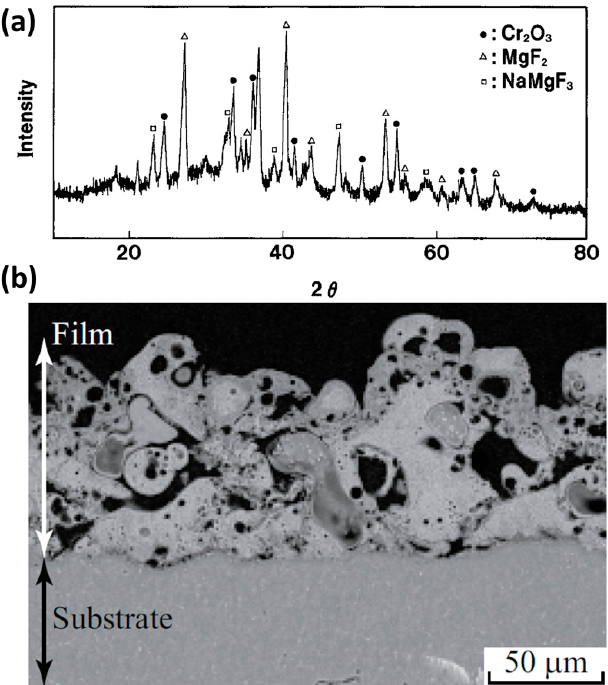
Figure 7. ( a ) X-ray diffraction pattern [71] and ( b ) backscattered electron cross-sectional micrograph of DOW17 coating on AZ91 alloy [72], the latter produced by applying constant current with the voltage rising to 200 V.